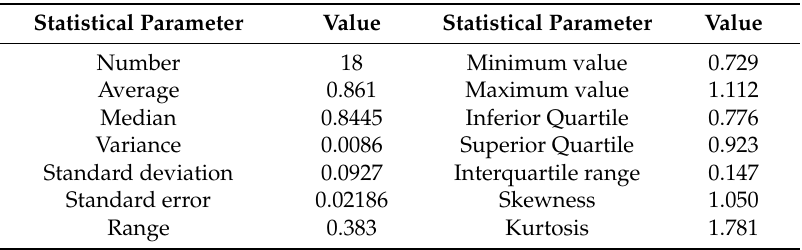
Table 5. Statistical analysis of the flexural strength of samples from the same batch.